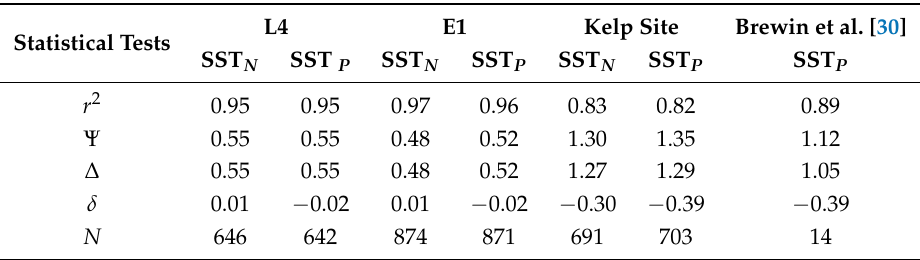
Table 1. Statistical tests between in situ SST data and AVHRR SST N and SST P products, at three sites (L4, E1 and the kelp site). For comparison, the equivalent statistics are provided from the Brewin et al. [30] study for AVHRR SST P products and in situ SST collected by surfers in the nearshore (see their Figure 7b at ± 3h difference), acknowledging a slightly different match-up method was used in their study see Section 2.5.3 of